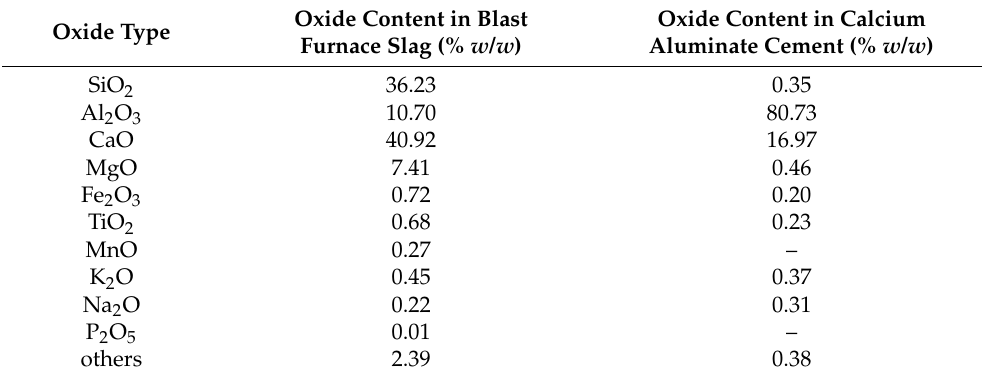
Table 1. Elemental composition of blast furnace slag and high alumina cement.